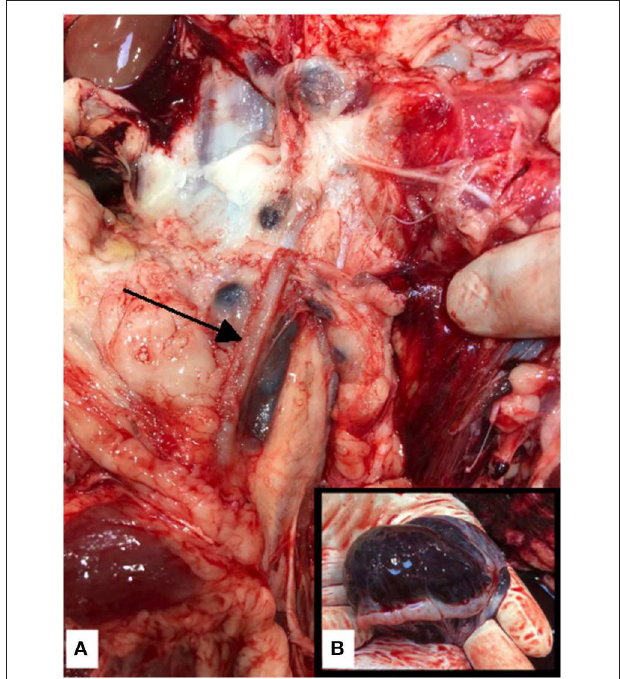
FIGURE 3 | (A) Post mortem photograph of the left external iliac vein. The venous stents were identified in the right and left (arrow) external iliac veins without associated vessel perforation or thrombi, precluding the stents as the cause of the fatal hemoabdomen. (B) Post mortem photograph of the left ovary. The left ovary was expanded with blood—ovarian hemorrhage was considered to be the source of hemorrhage and thus the cause of death. The right ovary was considered to be normal in size and had pinpoint foci of hemorrhage with histological retention of the normal